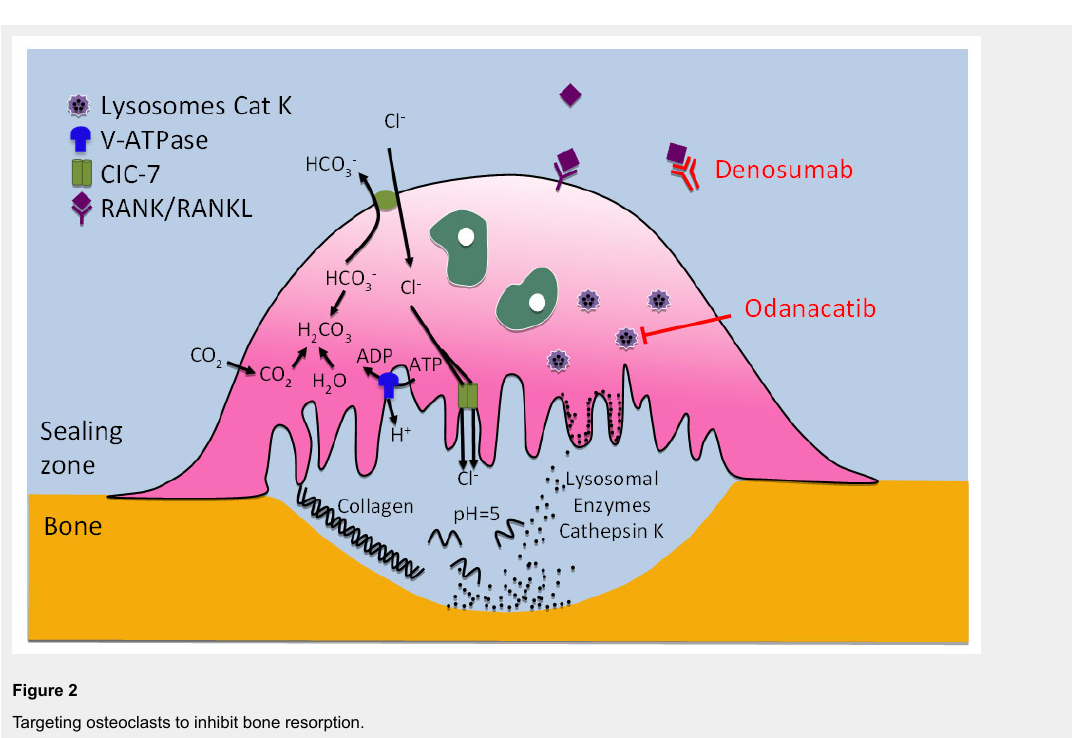
Targeting osteoclasts to inhibit bone resorption. By binding to the RANK-ligand (RANKL), the recombinant human IgG2-antibody denosumab prevents the interaction of RANKL with its receptor RANK, which leads to the inhibition of osteoclast formation, function, and survival, and to decreasing bone resorption. Odanacatib is an inhibitor of cathepsin K, a lysosomal cysteine protease with high collagenase activity expressed predominantly in osteoclasts, which may suppress osteoclast function without impairing osteoclast viability, thus preserving the osteoclast-osteoblast crosstalk and bone